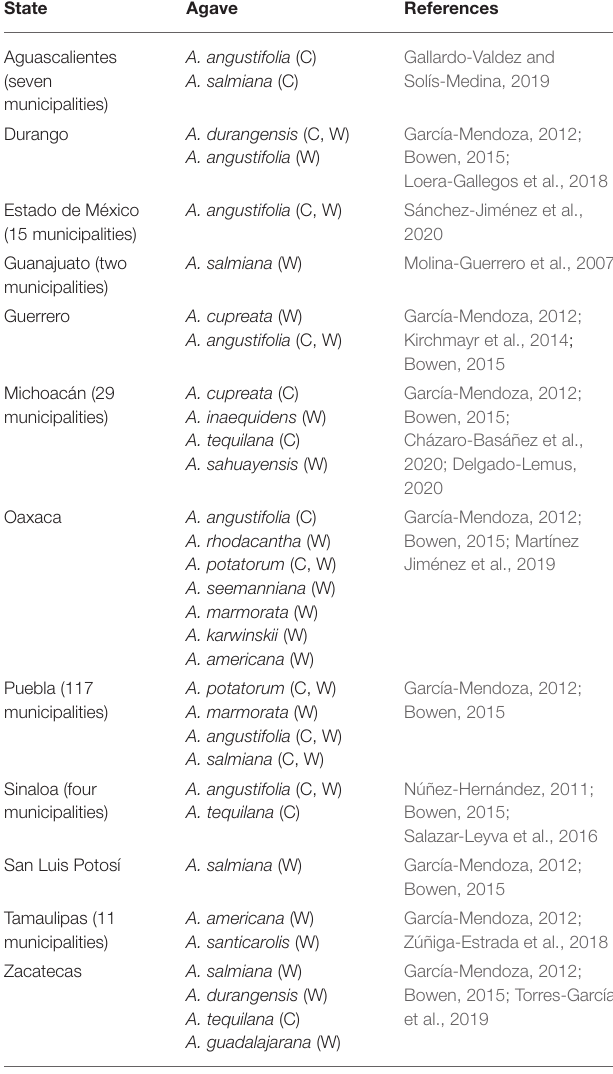
TABLE 4 | Agave species exploited in different production regions considered in the NOM.